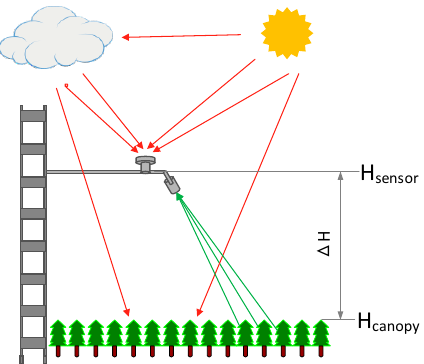
Figure 3. Illustration of the tower-based automatic spectral observation